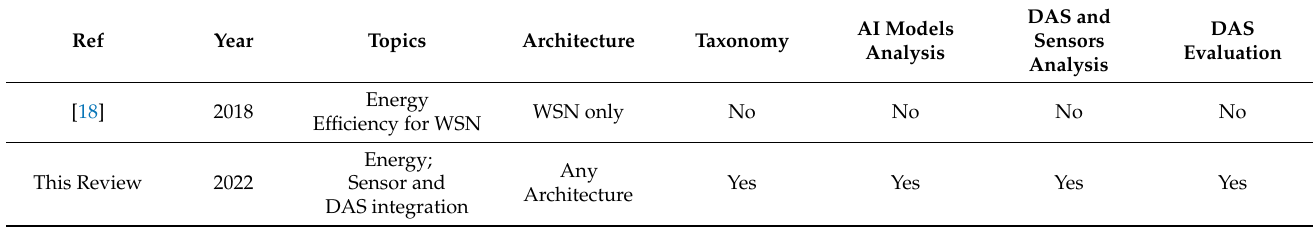
Table 4. Comparing Review